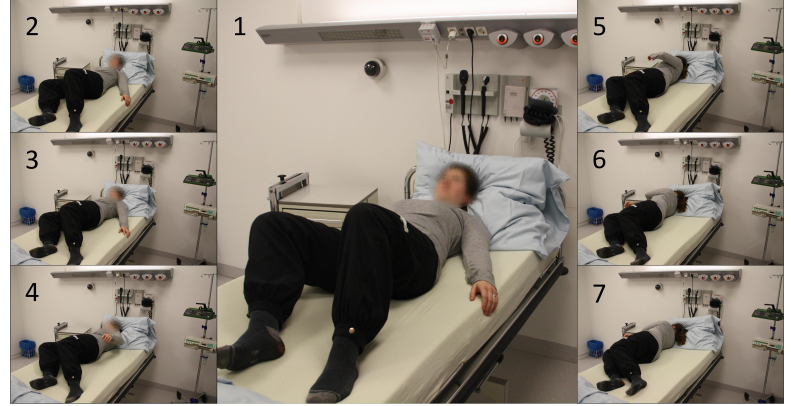
Figure 11. Procedure of a general restless phase, represented by lateral changes of position due to rotations of the test subject with equipped INBED wearable.